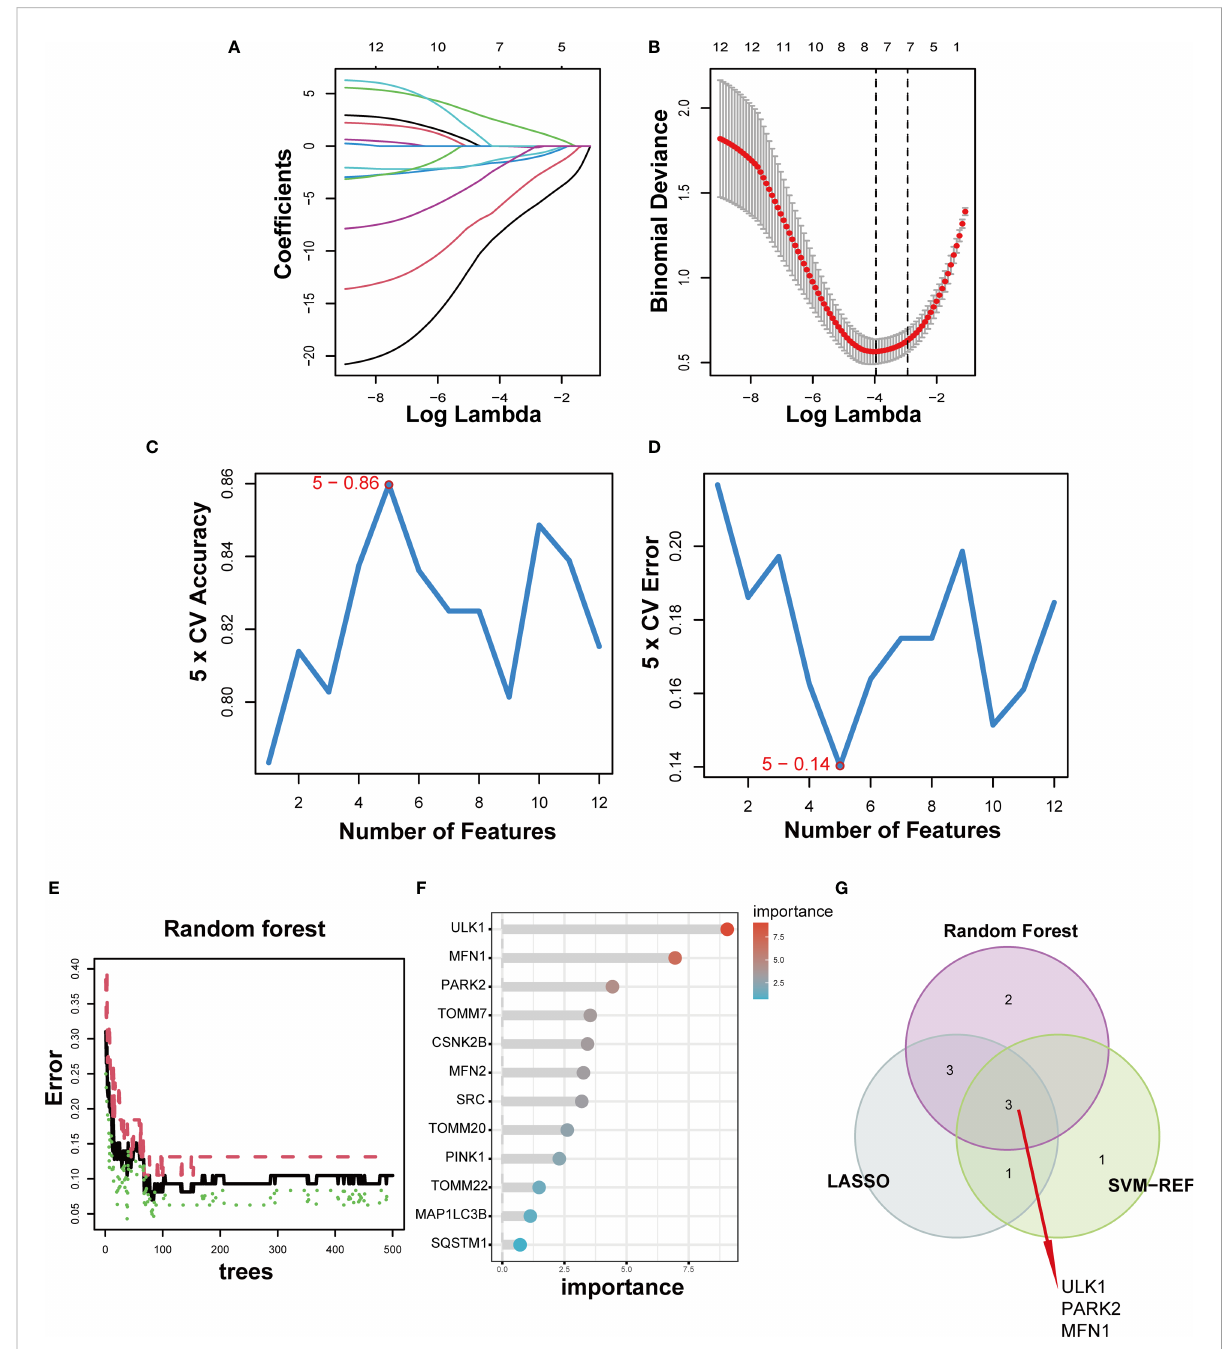
FIGURE 5 Three DE-MRGs were identi fi ed as diagnostic genes for DN. (A, B) Regression coef fi cient path diagram and cross-validation curves in LASSO logistic regression algorithm. (C, D) The curve of change in the predicted true and error value of each gene in SVM-RFE algorithm. (E, F) The identi fi cation of feature importance based on random forests. (G) Venn diagram demonstrates the intersection of diagnostic markers obtained from the three